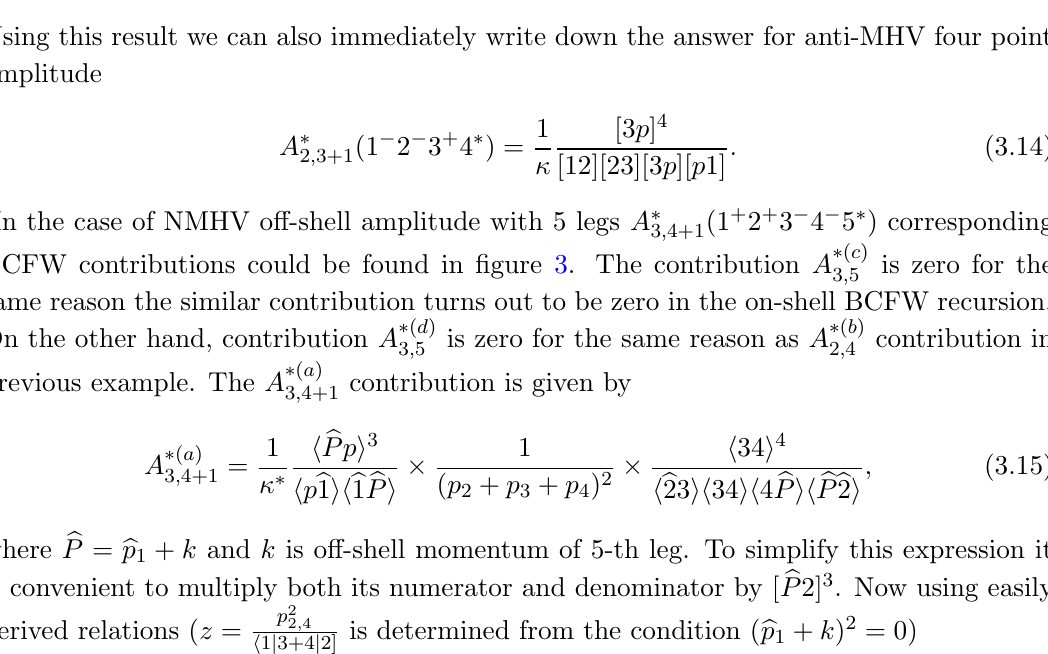
(1 + 2 + 3 (cid:0) 4 (cid:0) 5 (cid:3) ) for the case of [1 ; 2 i 3 ; 4+1